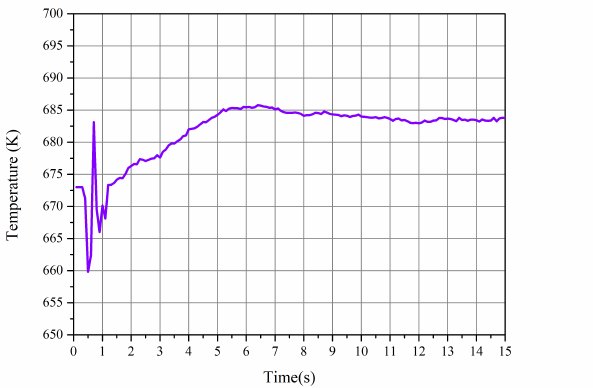
Figure 6. Time-evolution of temperature at the outlet of the methanation reactor.